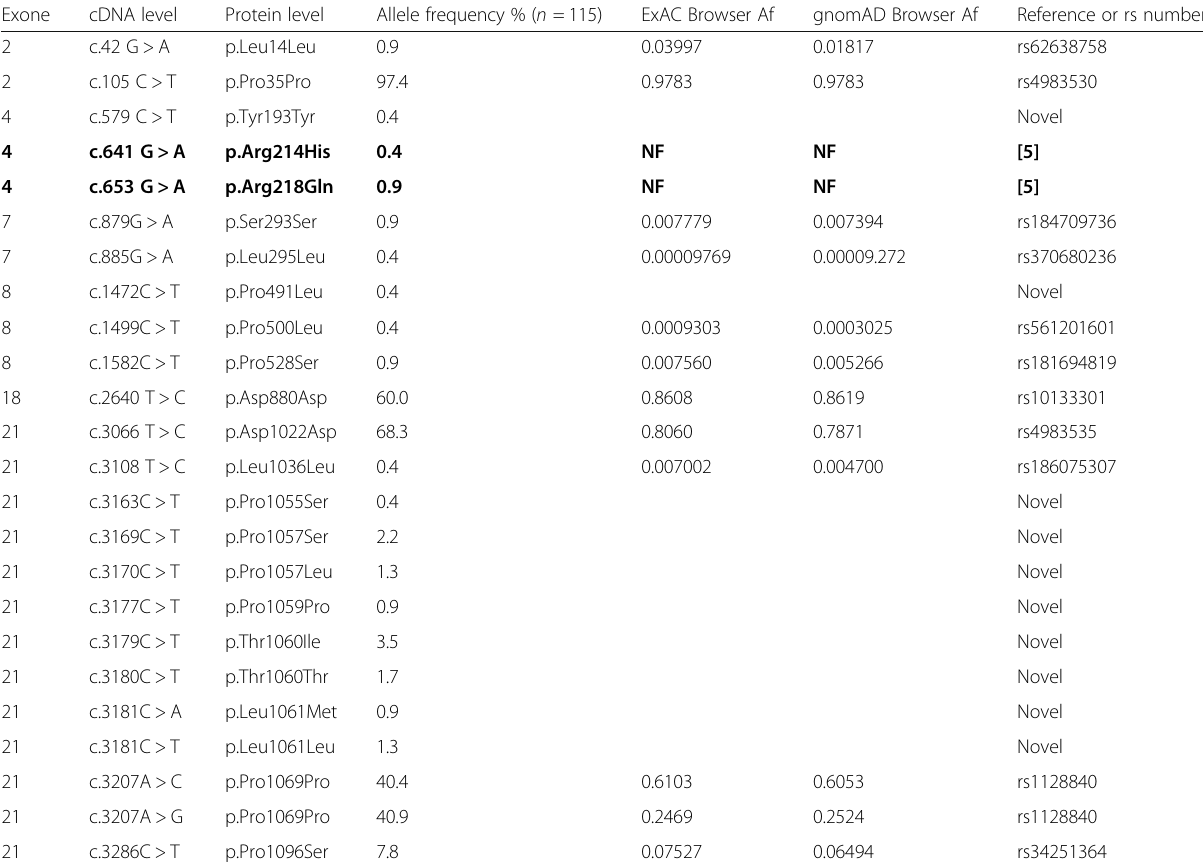
Table 2 All INF2 exonic variants found in our two cohorts of patients including allele frequencies from ExAC Browser and gnomAD Browser